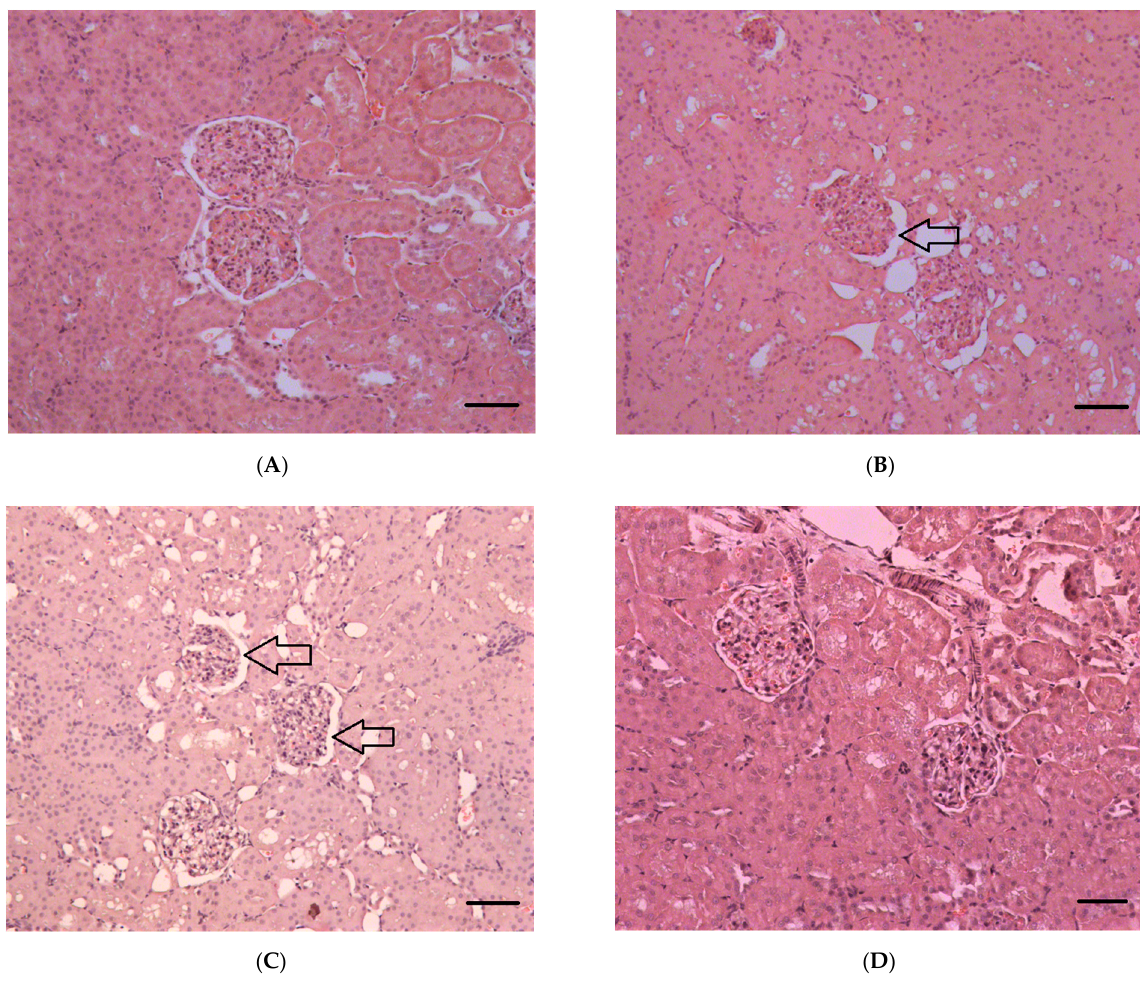
Figure 6. A section of the rat kidney cortex after exposure to POX at LD84. ( A )—control, ( B )—1 day, ( C )—3 days, and ( D )—7 days after the exposure. The arrows show enlargement of the urinary space. H&E stain. (×200). scale bar = 50 µm.